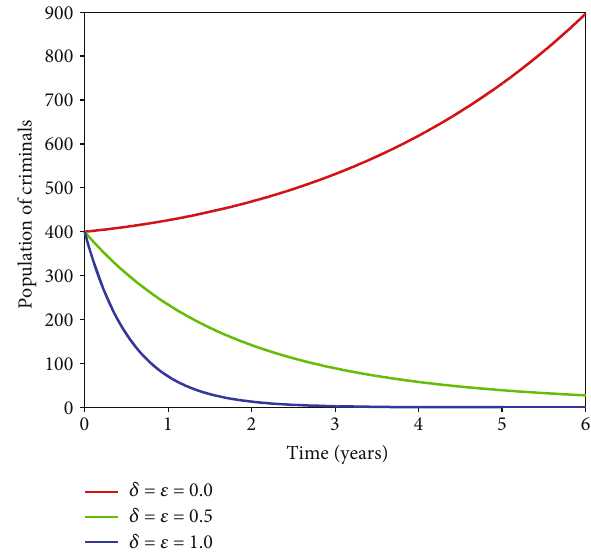
Figure 6: Simulation result showing the impact of vocational training and employment on crime population.